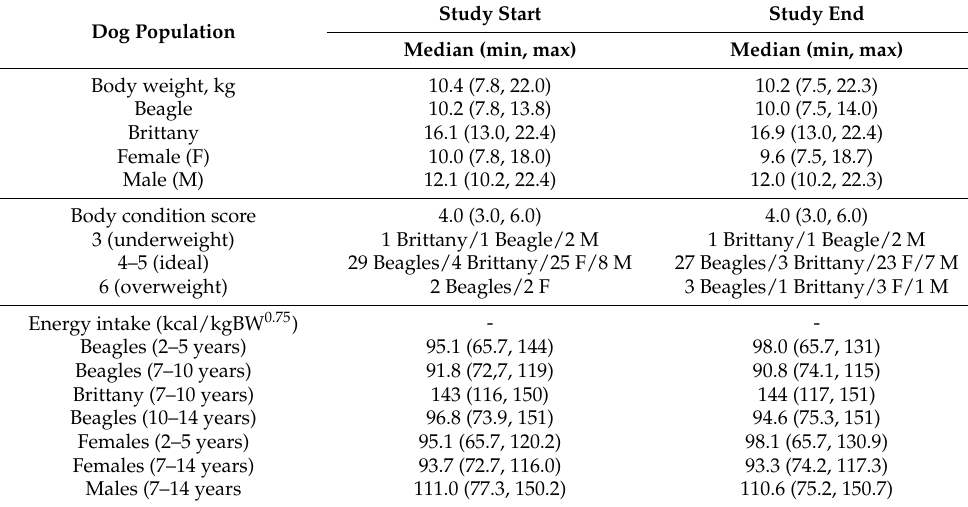
Table 3. Description of the dog population.